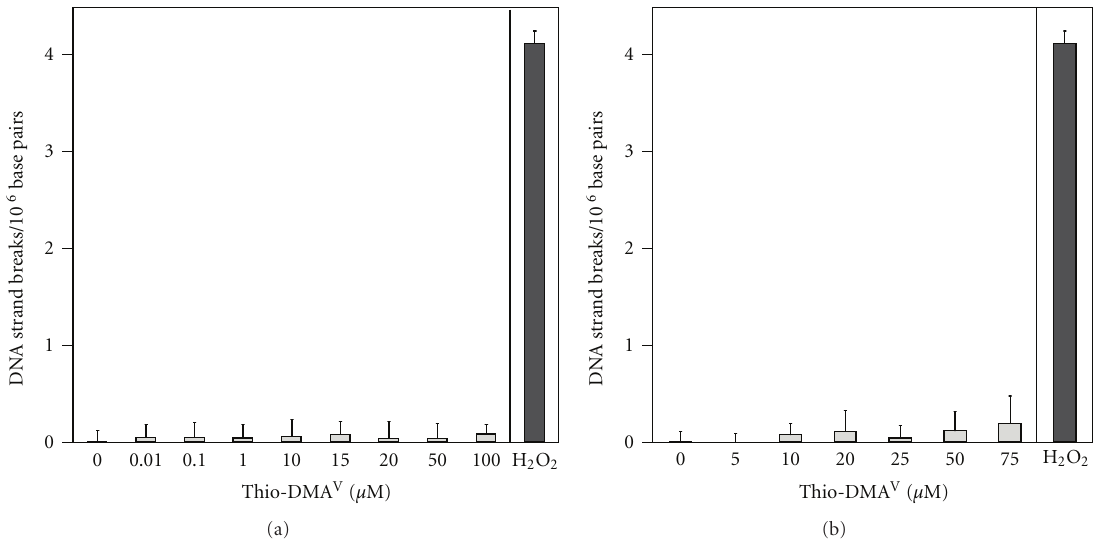
Figure 5: DNA strand break formation after 1h (a) and 24h (b) incubation with thio-DMA V in A549 cells. DNA strand breaks were quantified by alkaline unwinding; 5min incubation with 75 μ M H 2 O 2 served as positive control. Shown are mean values of at least six determinations +